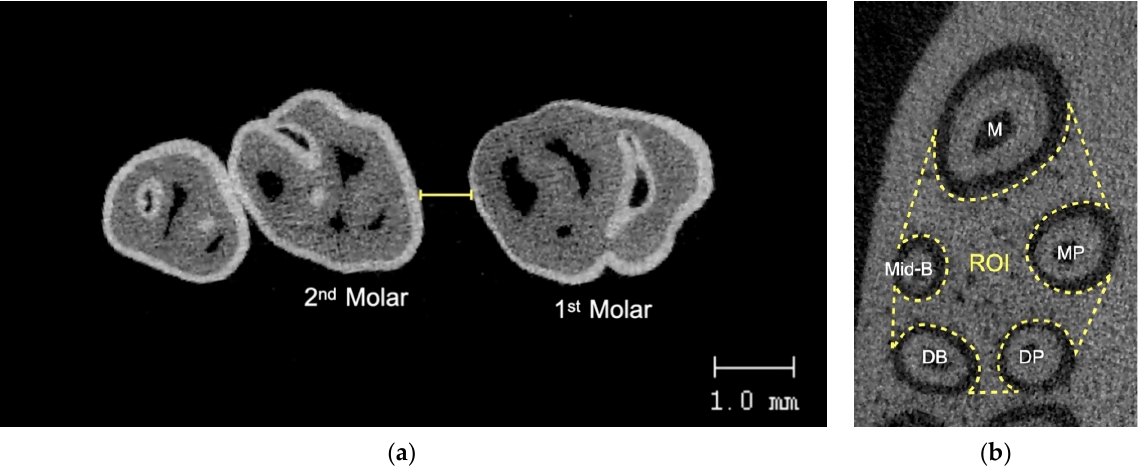
Figure 4. ( a ) Tooth movement measurement using micro-CT, ( b ) ROI for alveolar bone analysis. M = mesial root, Mid-B = mid-buccal, MP = mesiopalatal, DB = distobuccal, DP = distopalatal.